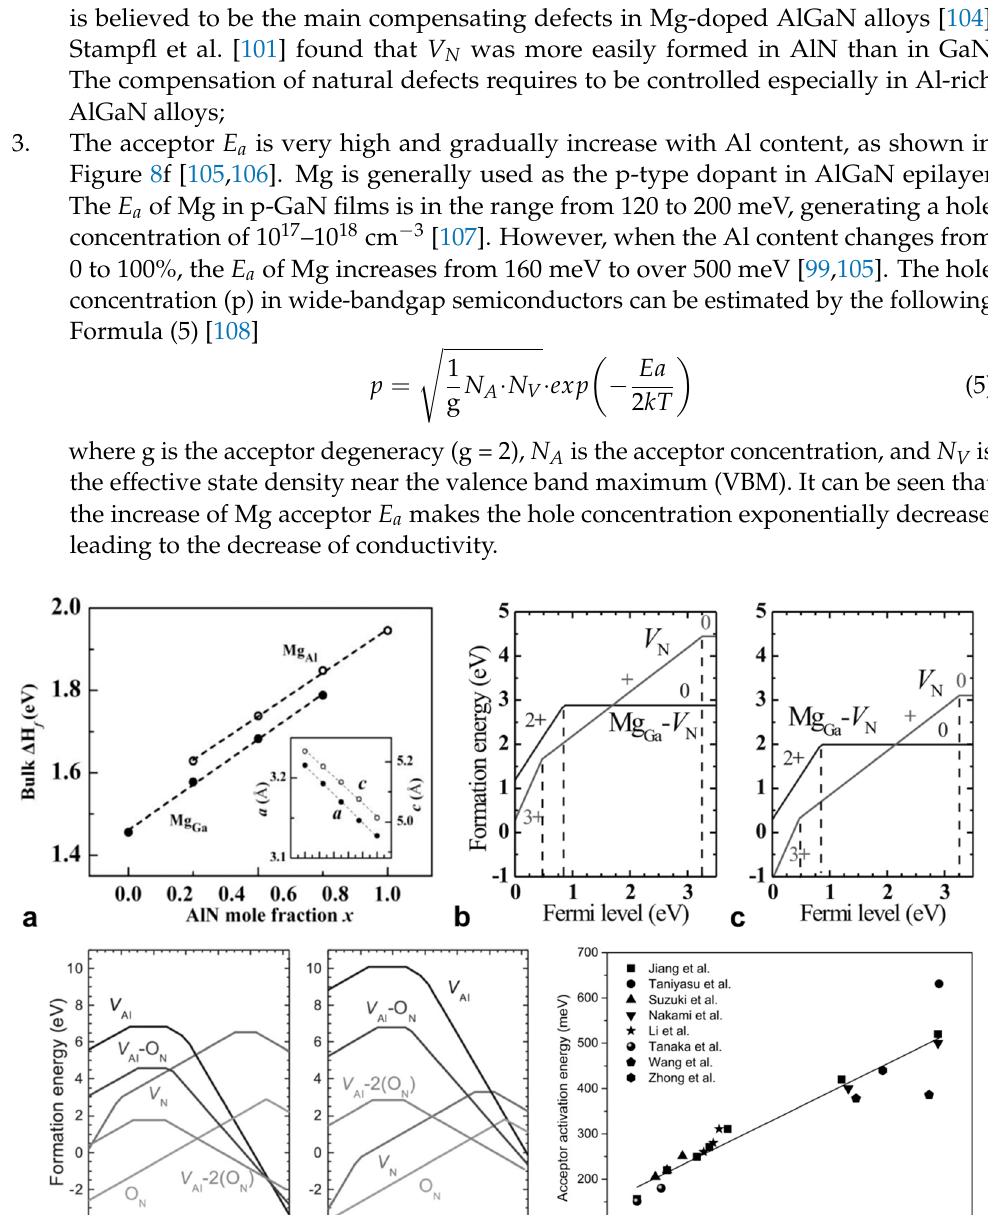
Figure 9. Schematic diagram of the Mg incorporation behavior in the AlGaN grown by the MSE technique. ( a ) When the interruption interval is long, only some peaks distribute locally at the inter- ruptions after Mg segregation and diffusion. ( b ) After optimizing the interruption interval, a high and uniform Mg distribution over the entire AlGaN epilayer was achieved [100]. Self-compensation by V N complexes can be suppressed by elevating V/III ratio during growth [71,99,104] and defect quasi Fermi level (dQFL) method [110]. Nakarmi et al. [104]